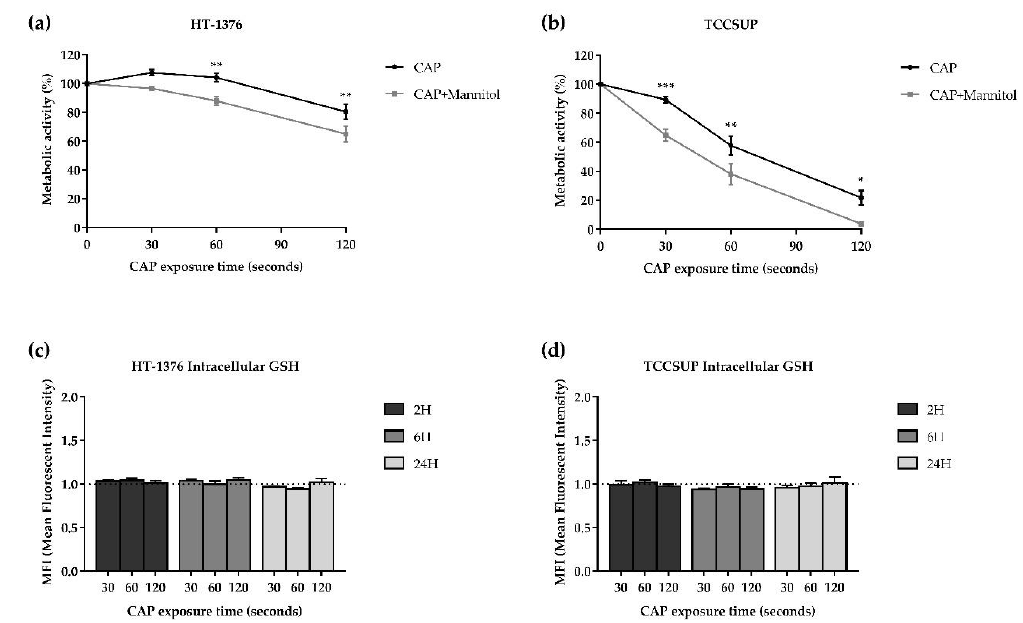
Figure 4. CAP treatment together with D-mannitol decreased the metabolic activity in both HT-1376 ( a ) and TCCSUP ( b ) cell lines. No differences were observed in the intracellular content of GSH in both HT-1376 ( c ) and TCCSUP ( d ) cell lines. The hydroxyl radical was indirectly evaluated using D-mannitol. The cells were treated with CAP or CAP with D-mannitol (CAP + Mannitol), and the cell proliferation was accessed by MTT 24 h after CAP treatment (n = 5 independent experiments in triplicate). Exposure time-response curves were plotted, and the results are expressed as the mean ± SEM of the per- centage of metabolic activity normalized to control. Statistical differences between CAP and CAP + Mannitol are repre- sented, being p value reported as * p ≤ 0.05, ** p ≤ 0.01, *** p ≤ 0.001, **** p ≤ 0.0001. Intracellular content of GSH was evaluated by fluorescence using the fluorescent orange mercury compound, 2, 6, and 24 h after CAP treatment (n ≥ 4 independent experiments in triplicate). Results are expressed as the mean ± SEM of the MFIs normalized to control.